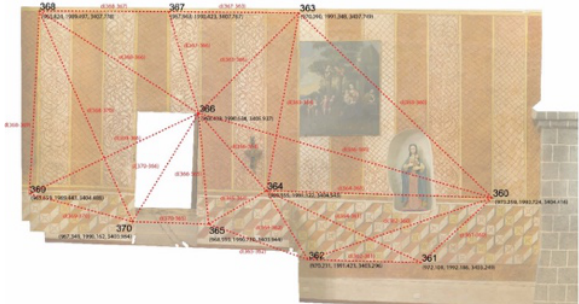
Figure 17 . Ortho-corrected image used as a reference to triangulate measurements in Scenario 2.